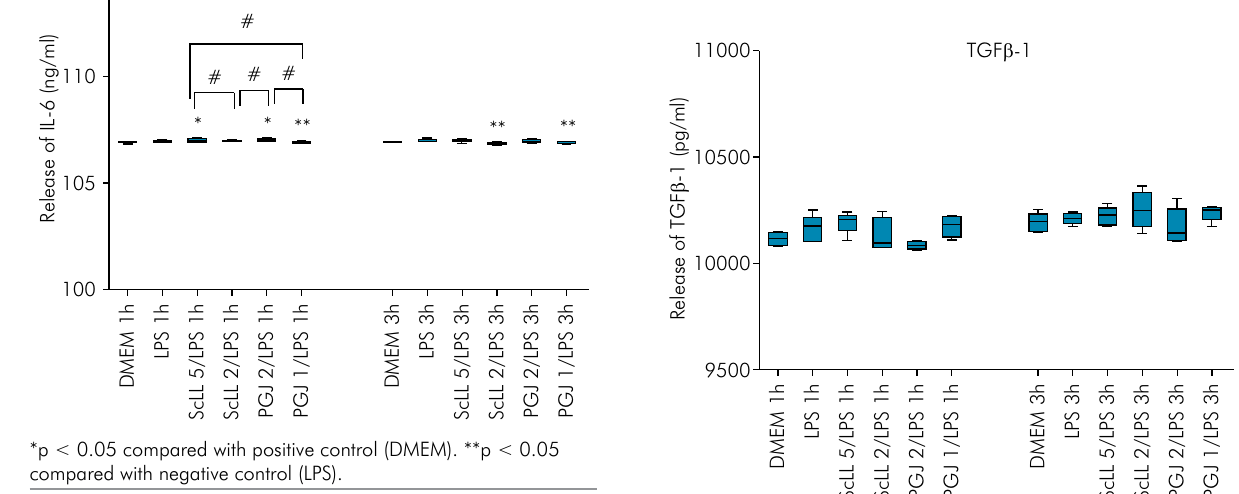
Figure 2. Release of IL-6 in HGFs examined by Elisa at 1 and 3 h. Statistical significance was determined using one-way ANOVA and Dunnett’s test. #p<0.05 compared among the experimental groups.